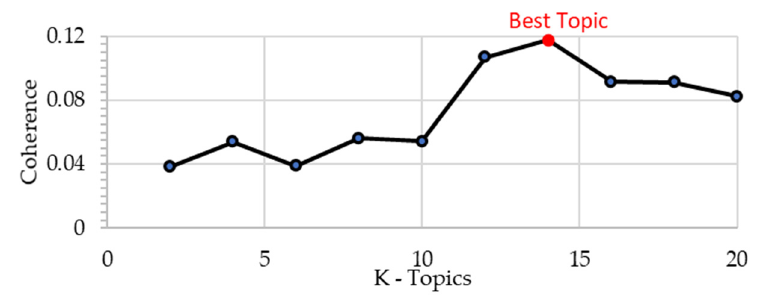
Figure 4. Coherence of topics.